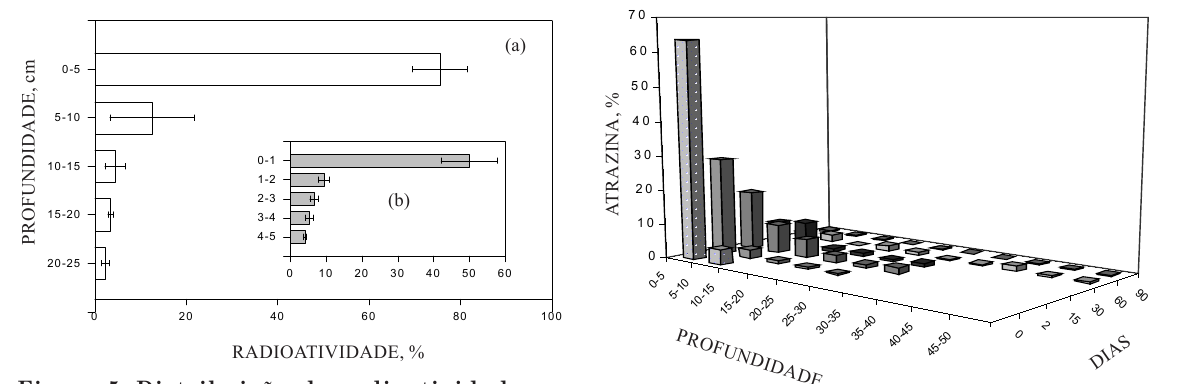
Figura 5. Distribuição de radioatividade em profundidade (a = % radioatividade até os 25 cm de 5 em 5 cm, b = % radioatividade nos primeiros 5 cm). As barras verticais indicam o